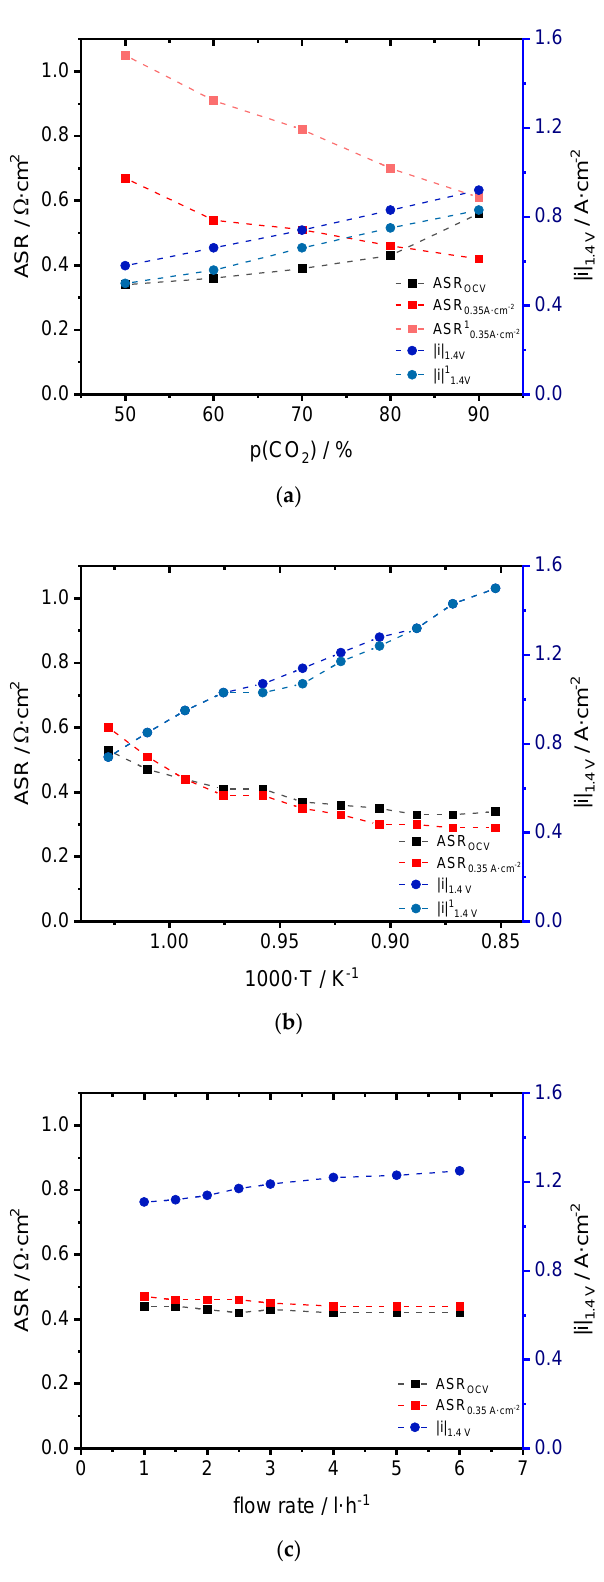
Figure 2. ( a ) ASR, | i | 1.4 V and OCV for various ratios of CO 2 :CO at 800 ◦ C. ( b ) ASR, | i | 1.4 V and OCV for various temperatures for the ratio of CO 2 :CO of 80:20. ( c ) ASR, | i | 1.4 V and OCV for varied flow rate for a CO 2 :CO ratio of 80:20 at 800 ◦ C. 1 Two values are given because of the hysteresis. The first denotes the forward scan and the second the backward scan of the iV curve.